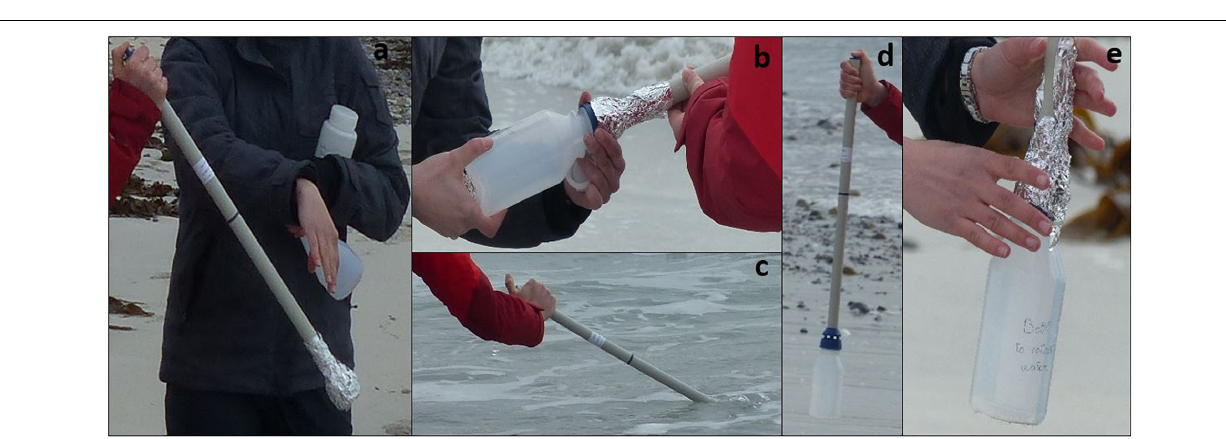
FIGURE 5 | Collection of surface seawater with a pole-water sampler using aluminum foil to avoid air contamination, (a) pole-water sampler protected from the air with aluminum foil, (b) remove aluminum foil at the end of pole and screw the bottle sampler, (c) put pole in the water, release the button to collect water, (d) press the button to avoid air coming into contact with the seawater, (e) put aluminum foil around the apertures to prevent air contamination and release the button prior to transferring the water to the